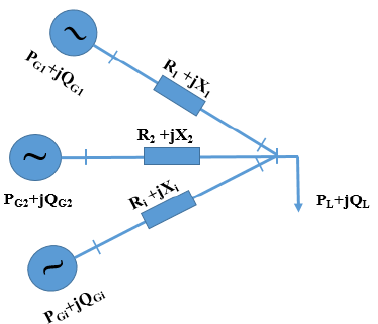
Figure 1. Distributed generators connected to a load through three cable lines.